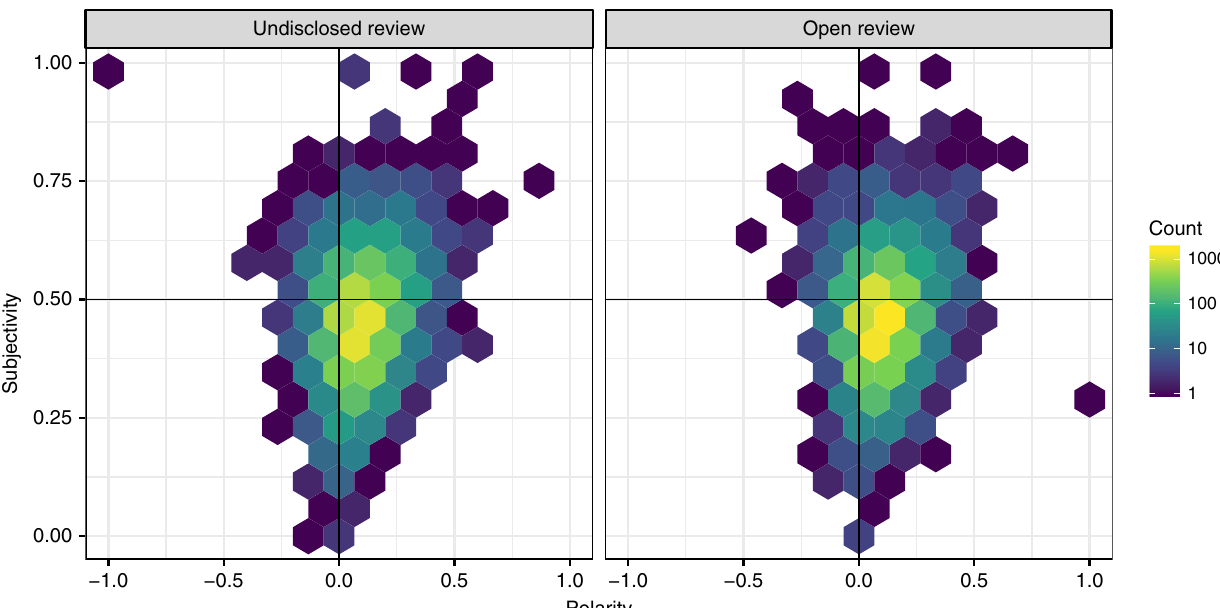
Fig. 5 Distribution of polarity and subjectivity in the report text before and during the pilot. Note that for polarity, the interval was [ − 1, 1], larger numbers indicating a more positive tone, while for subjectivity the interval was [0, 1], higher numbers indicating more subjective reports